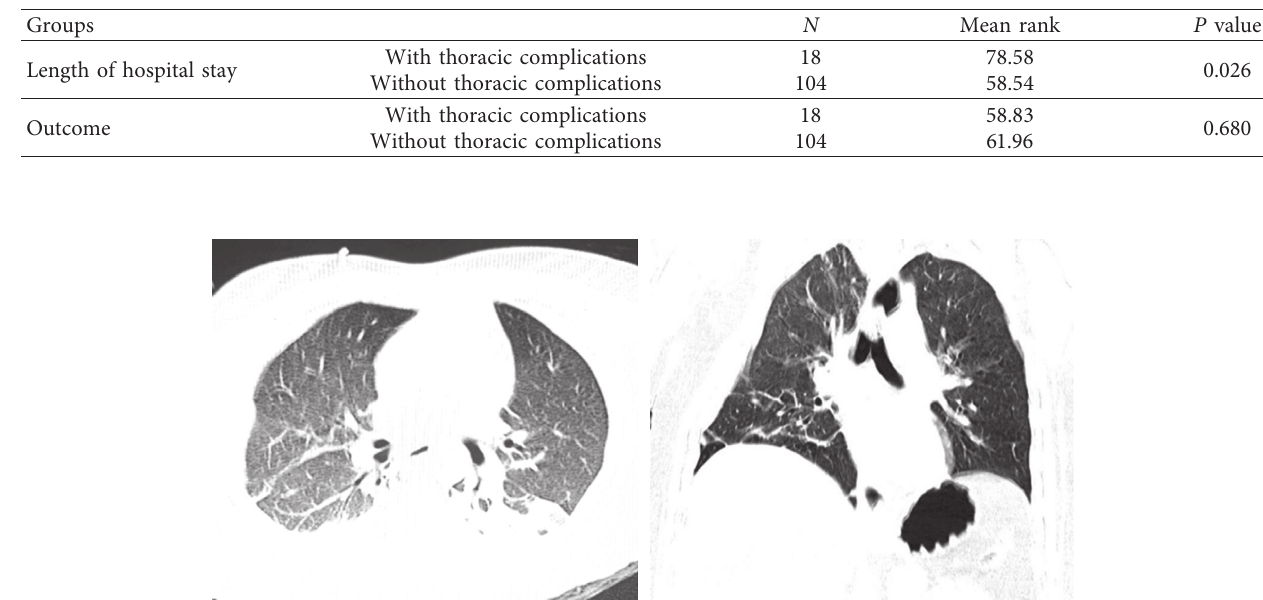
Table 5: Comparison between group of COVID patients in the ICU who had thoracic complications and who did not, regarding length of hospital stay and prognosis.